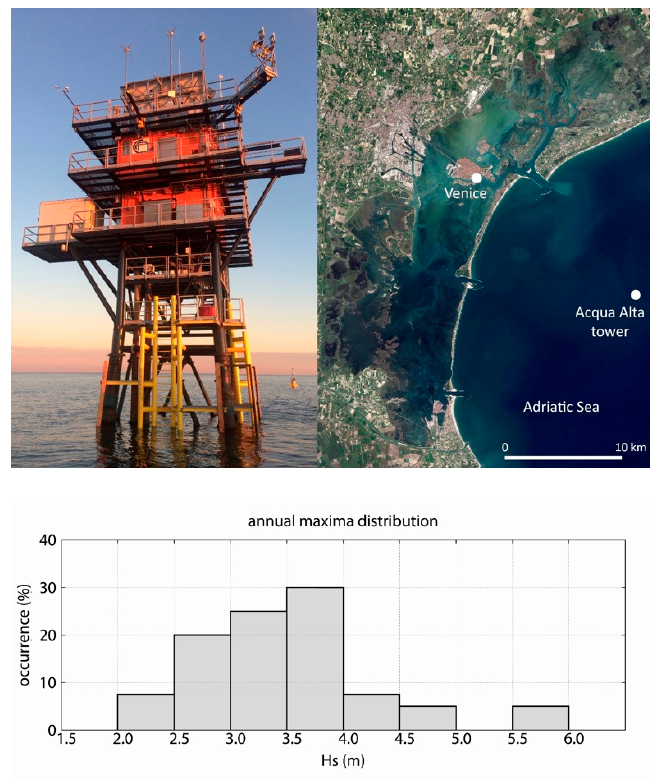
Figure 5. ISMAR oceanographic tower “Acqua Alta” (top-left panel) in the northern end of the Adriatic Sea, in front of Venice (top-right panel, the dot shows the position of the tower, 15 km offshore), and local long-term distribution of the annual maximum significant wave heights (bottom panel). Base image of top-right panel from NASA Earth Observatory images, by Jesse Allen and Robert Simmon, using Landsat data from the U.S. Geological Survey.